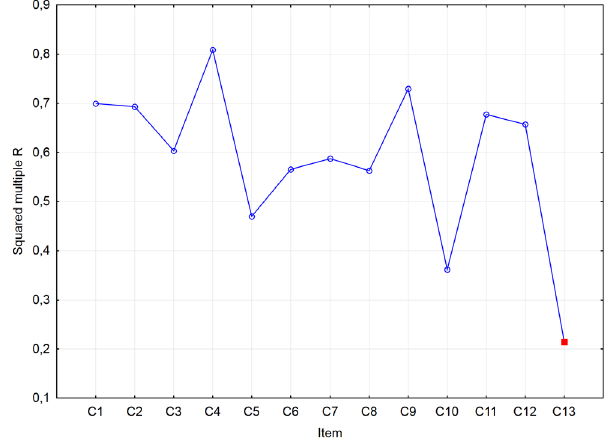
Fig. 2. Values of the coefficient of determination after elimination of the relevant item